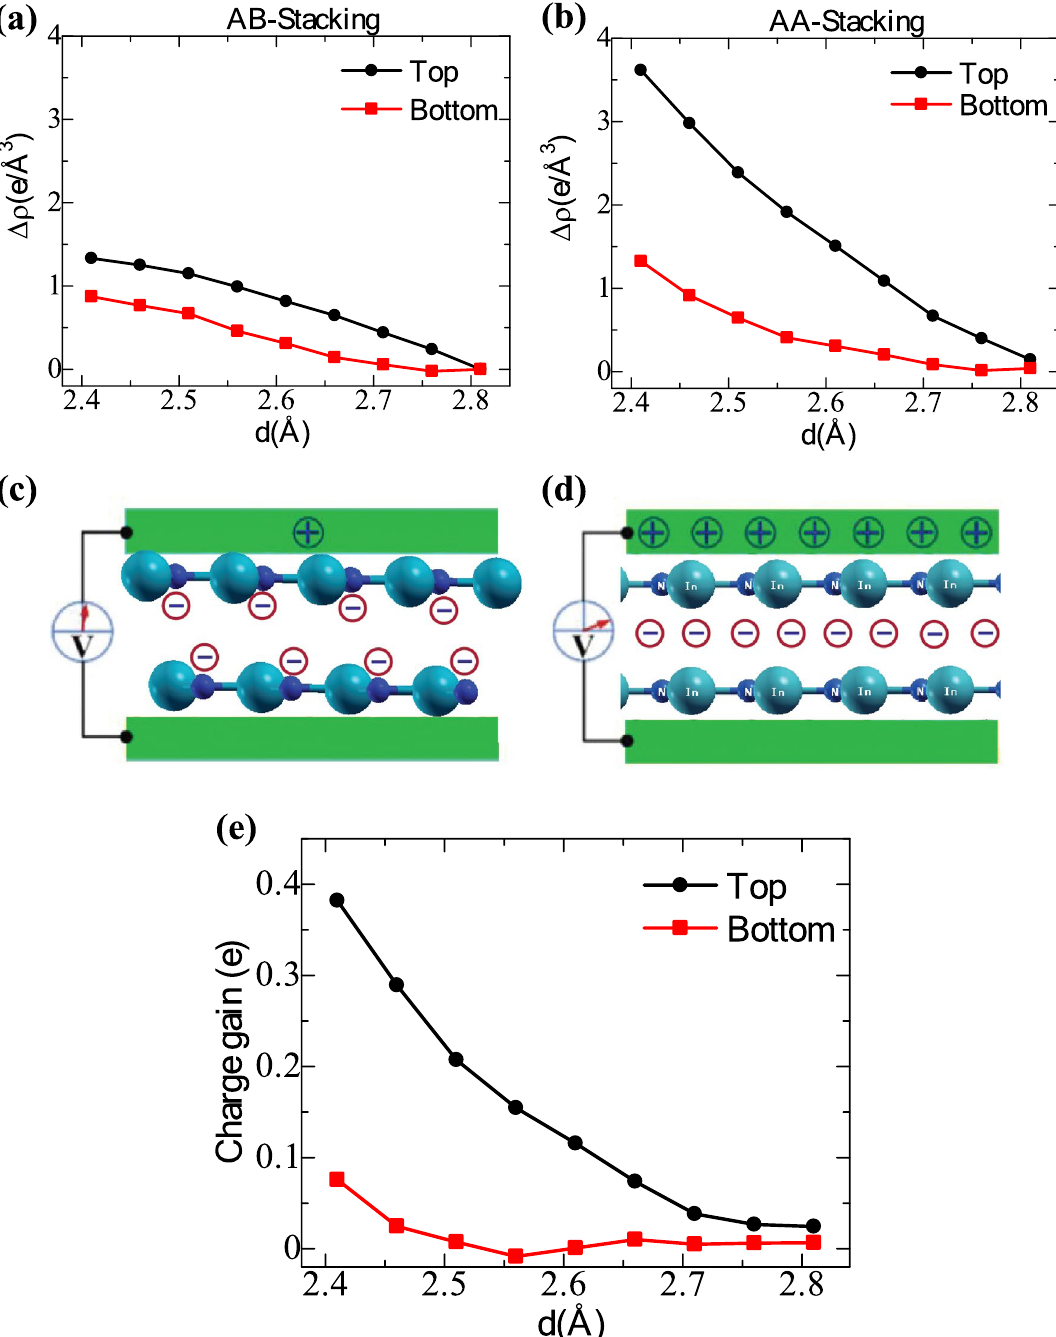
Figure 5. ( a , b ) Average charge density differences at 0.001 e/Å 3 on the two monolayers of the InN bilayer